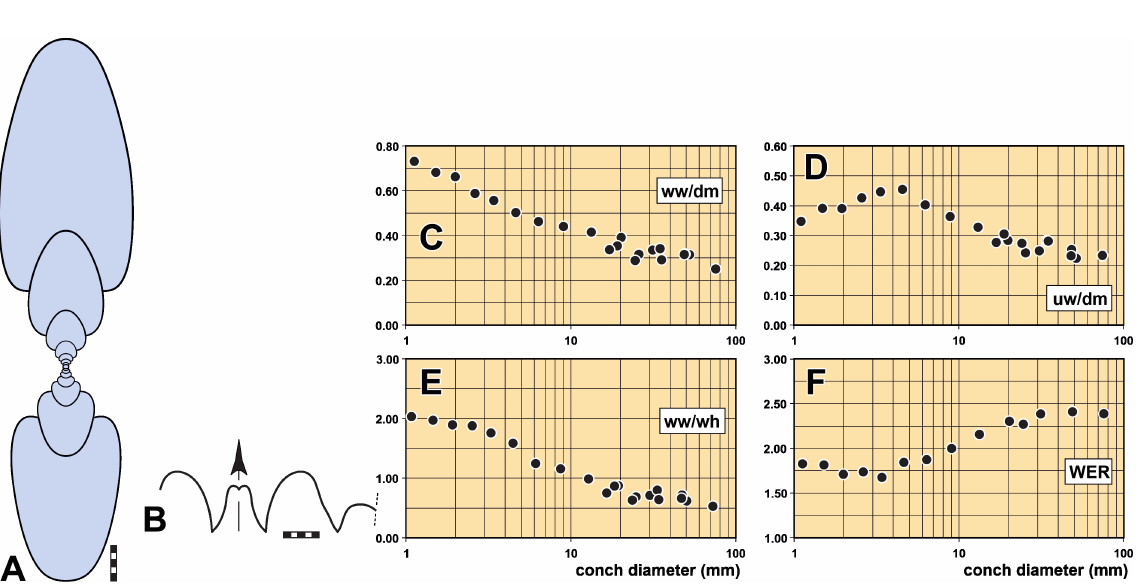
Fig. 18. Koenenites lamellosus (Sandberger & Sandberger, 1851). A . Cross section of specimen MB.C.22201 from Oberscheld (Königszug Mine). B . Suture line of specimen MB.C.22184 (Koch Coll.) from Oberscheld (Anna Mine), at dm = 29.0 mm, ww = 7.4 mm, wh = 11.1 mm. C–F . Ontogenetic trajectories of the cardinal conch parameters. Scale bar units = 1 mm.